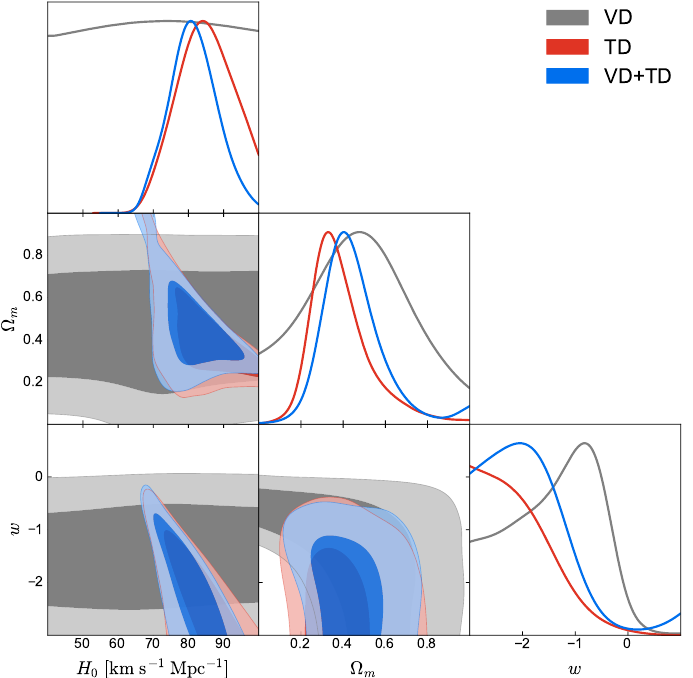
Figure 2. The constraints (68.3% and 95.4% confidence level) on the w CDM model from VD, TD, and